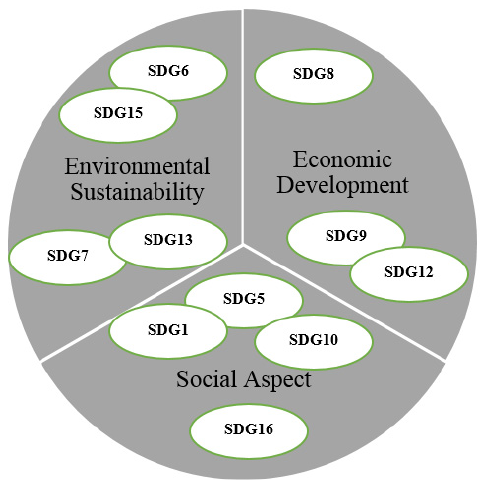
Figure 3. Sustainable development goals in mining according to [23].